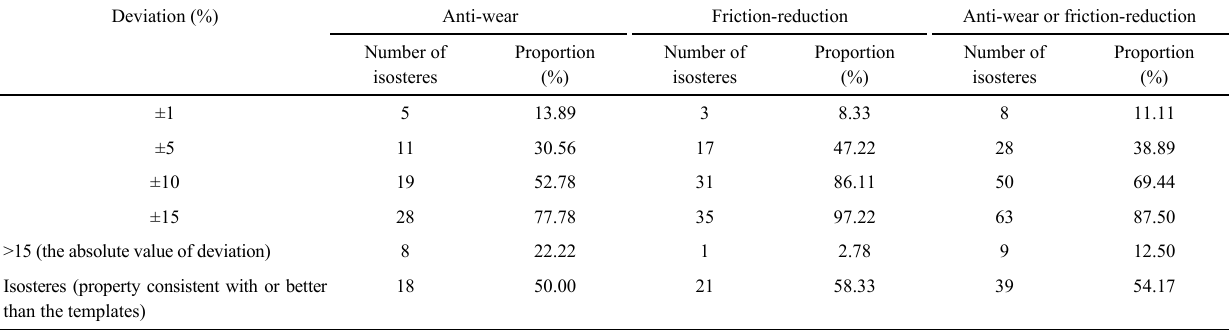
Table 3 Similarity assessment of isosteres based on thiobenzothiazole